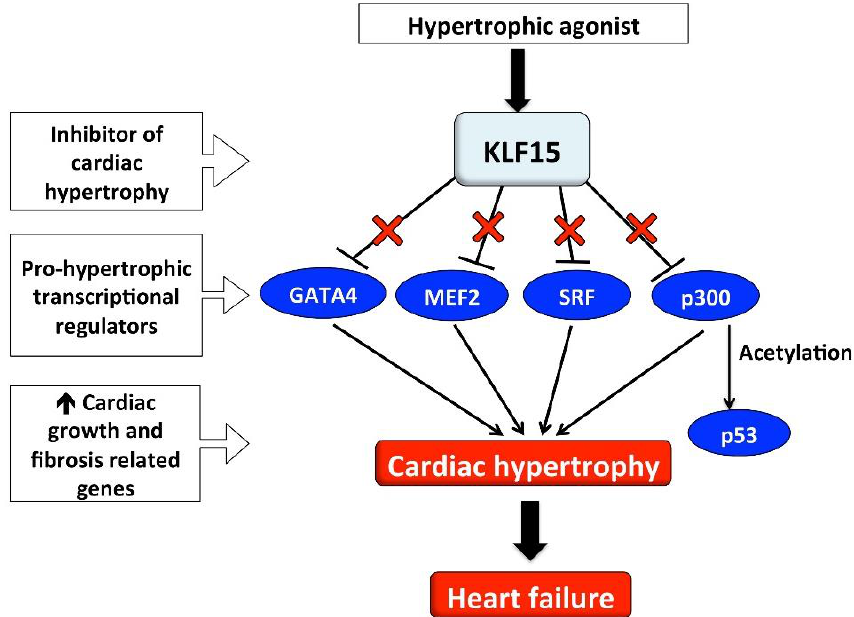
Figure 1. Schema illustrating how loss of the inhibitory effect of KLF15 on pro-hypertrophic cardiac transcriptional regulators may contribute to the development of LVH and heart failure. ↑ Increased; X in red font represents the inhibitory effect; GATA4, GATA binding protein 4; KLF15, Kruppel-like factor 15; MEF2, myocyte enhancer factor 2; SRF, serum response factor.